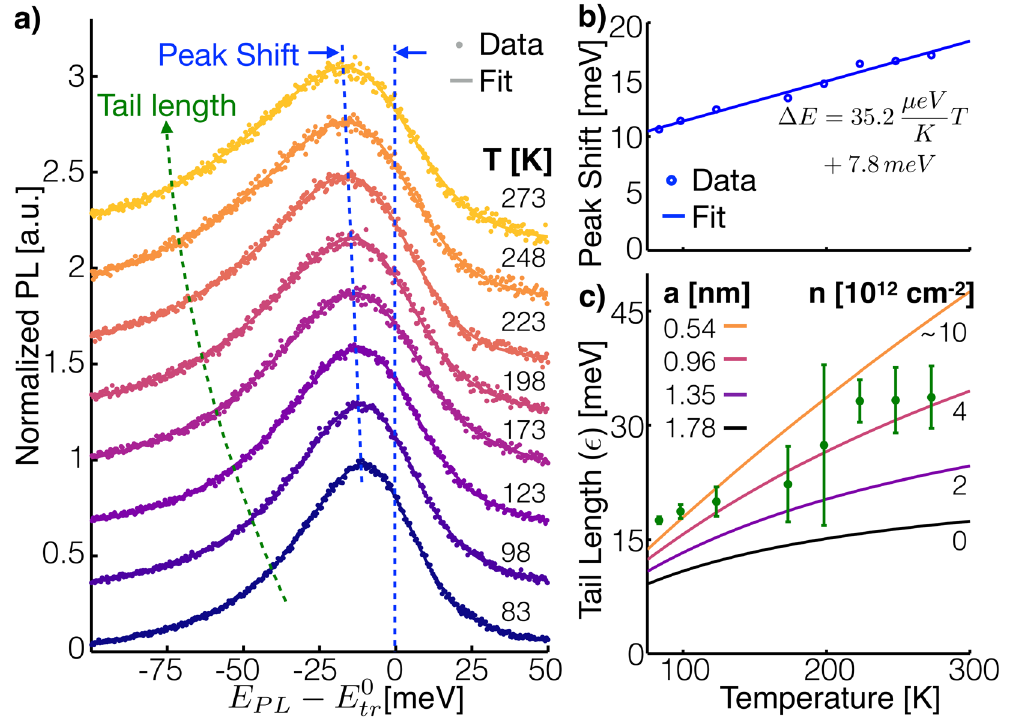
Figure 4. ( a ) Trion contribution to the PL. The data points are the PL with background and exciton contributions subtracted, and the fit is only the trion portion of the fit function. As the temperature increases, the peak position red-shifts and the low-energy tail gets longer. ( b ) Difference between the energy with highest 0 from the spectra in panel a. ( c ) Extracted trion tail length, ε , as well as theoretical curves intensity and E tr assuming various values for a .